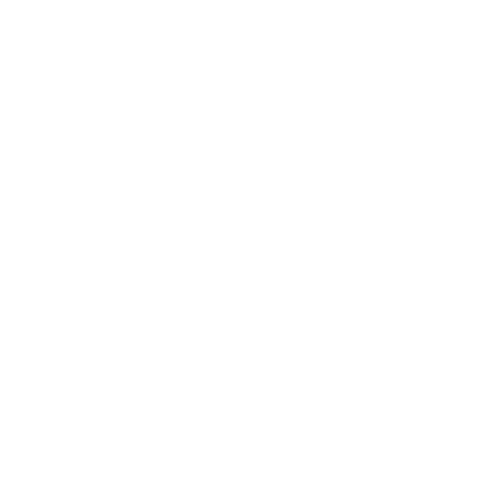
Figure 1. Comparison of early and late-onset postoperative pulmonary complications by groups. CompMinor early postoperative pulmonary complications, CompMajor late-onset postoperative pulmonary